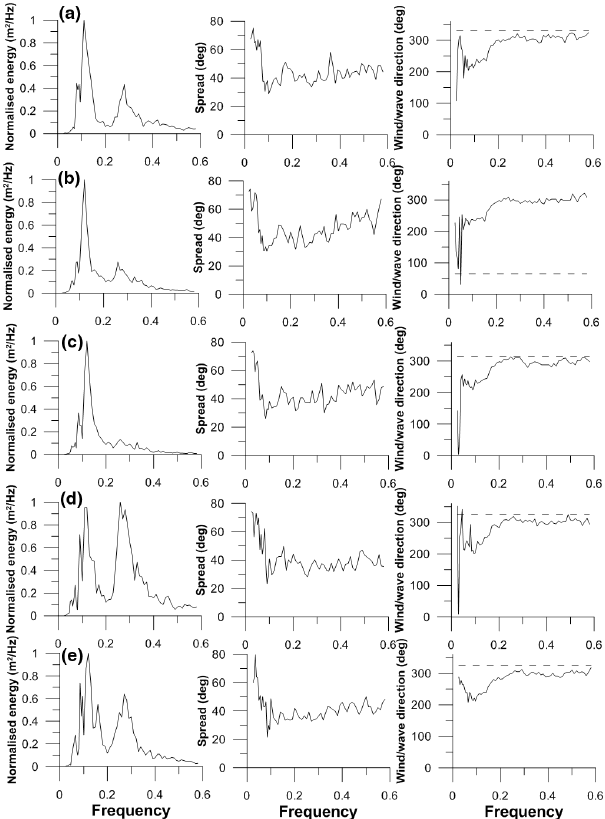
Fig. 5. Wave energy spectrum, wave spread and mean wave direc- tion (solid line) and wind direction (dashed line) at (a) 00:00h, (b) 06:00h, (c) 12:00h, (d) 18:00h and (e) 23:00h, respectively, off Goa during 9 May